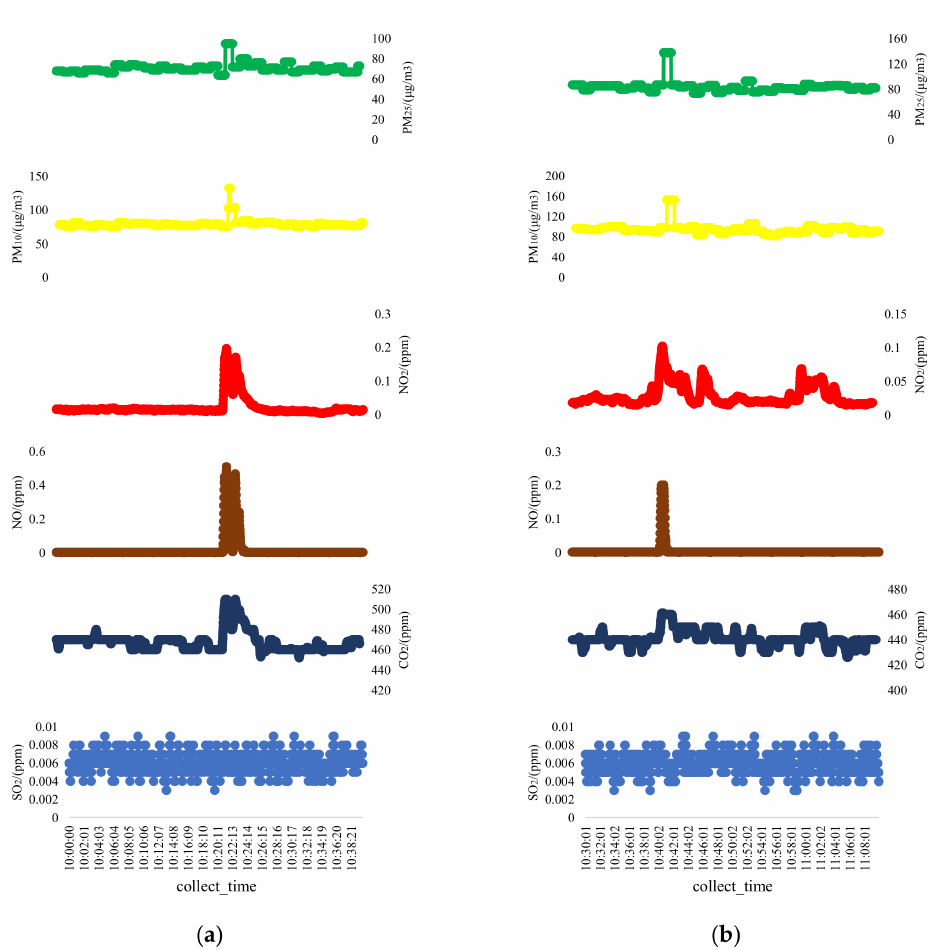
Figure 7. Measurement data of typical plumes from two groups of inland river ships: ( a ) plume 3, ( b ) plume